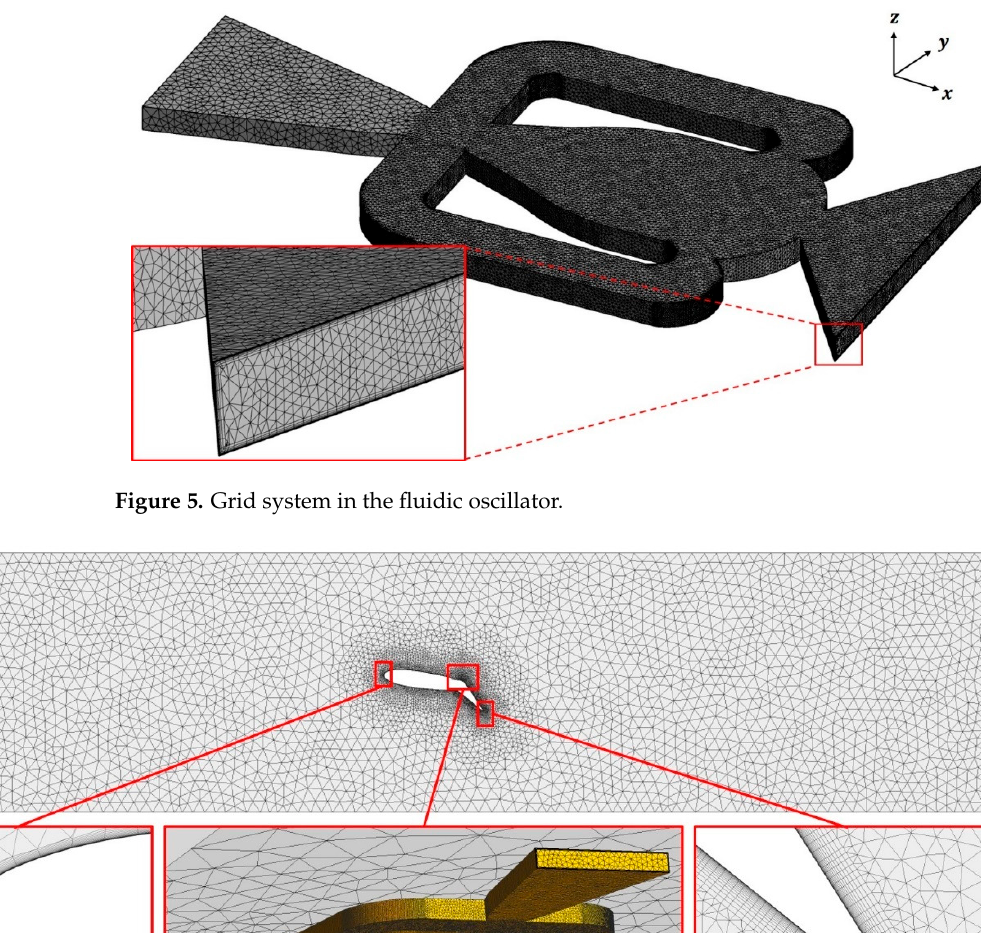
Figure 4. Computational domain using periodic boundary conditions [29].